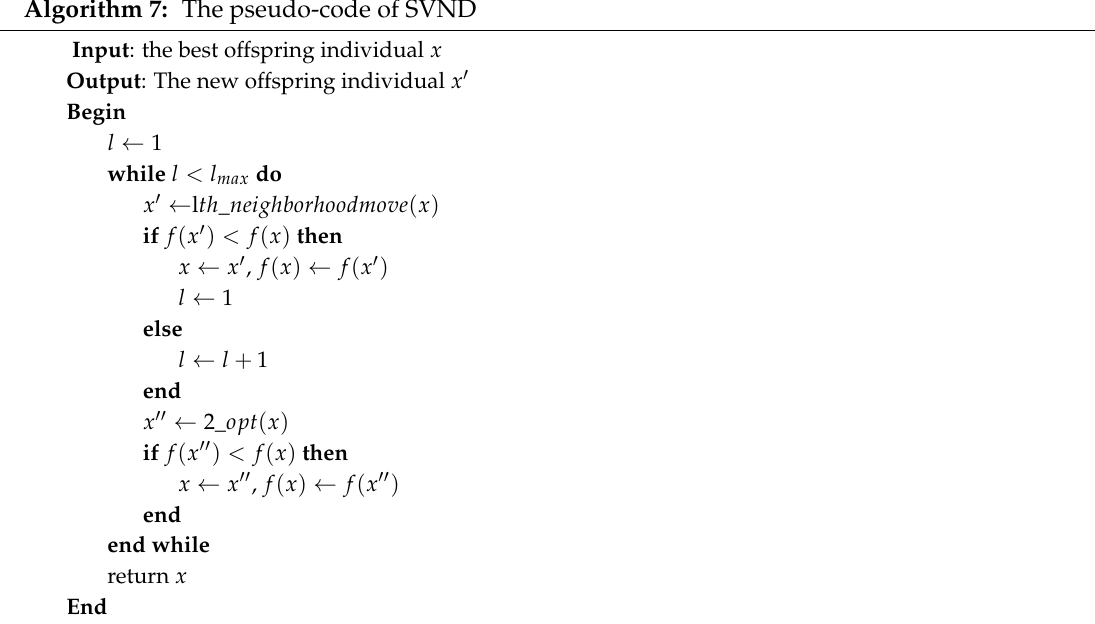
Algorithm 7: The pseudo-code of